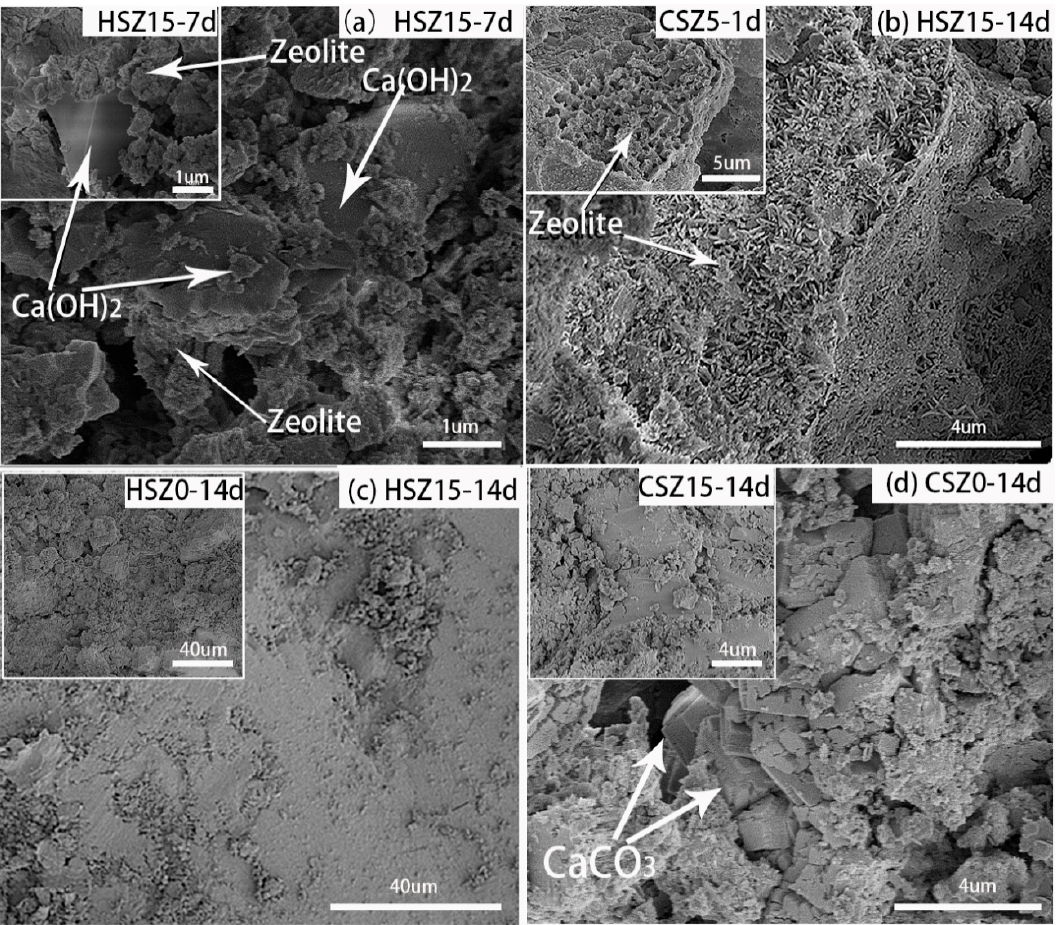
Figure 11. Field emission scanning electron microscopy (FE-SEM) morphologies of SZ specimens after the “H” or “C” process. ( a ) pozzolanic reaction of zeolite and Ca(OH) 2 in HSZ15-7d; ( b ) morphology of zeolite after “H” and “C” process; ( c ) the morphology of surface density in HSZ0-14d and HSZ15-14d; and ( d ) morphology of CSZ0-14d and CSZ15-14d. (H: hydration at different times; C: hydration at different time and subsequent 2 h carbonation).